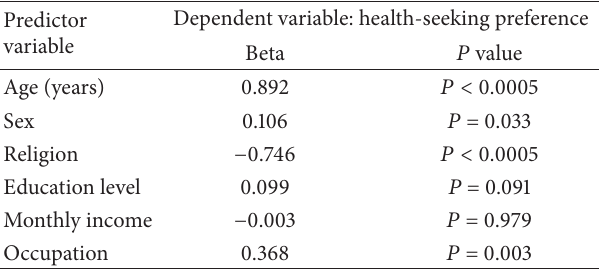
Table 5: Multiple linear